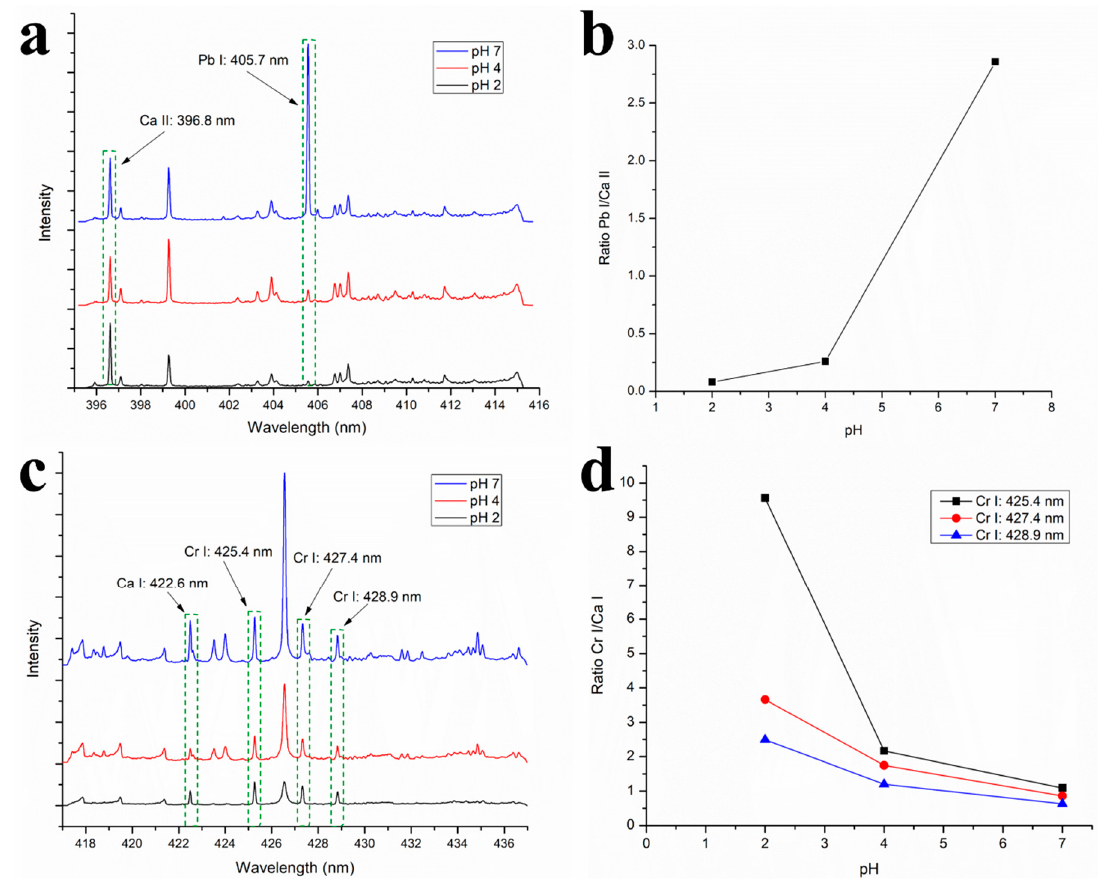
Figure 10. ( a ) LIBS spectra of B/COPUF and ( b ) the Pb I/Ca II signal peak ratio after the adsorption of Pb 2+ (100 µg/mL) and ( c ) LIBS spectra of B/COPUF and ( d ) the Cr I/Ca I signal peak ratio after the adsorption of Cr (VI) (100 µg/mL)